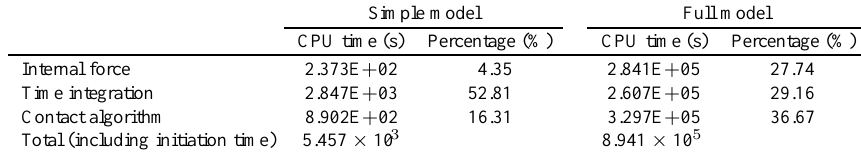
Table 3 Comparison of CPU times for solving simple and full